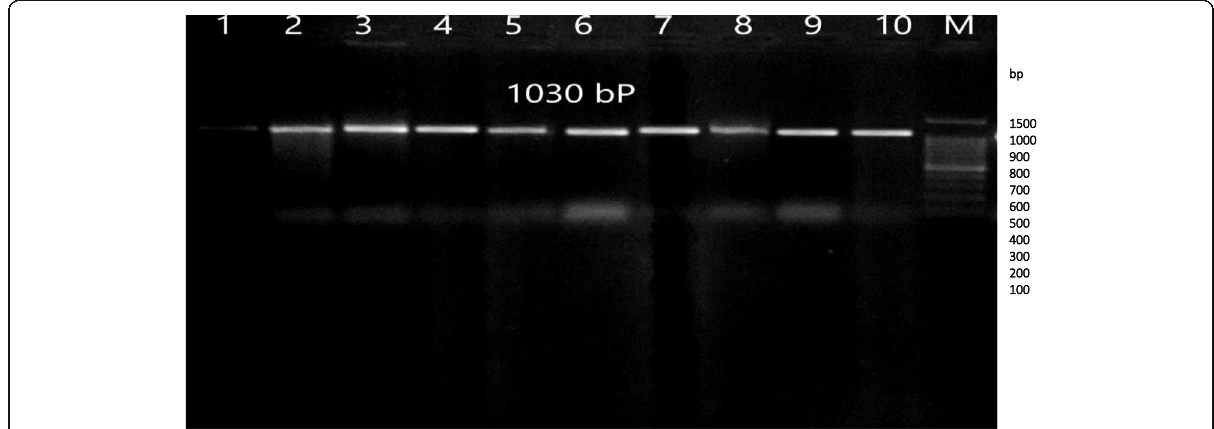
Fig. 1 Agarose gel electrophoresis of ten strains of OmpH gene of Pasteurella multocida . Lanes 1 – 10 PCR product and M 100 bp DNA